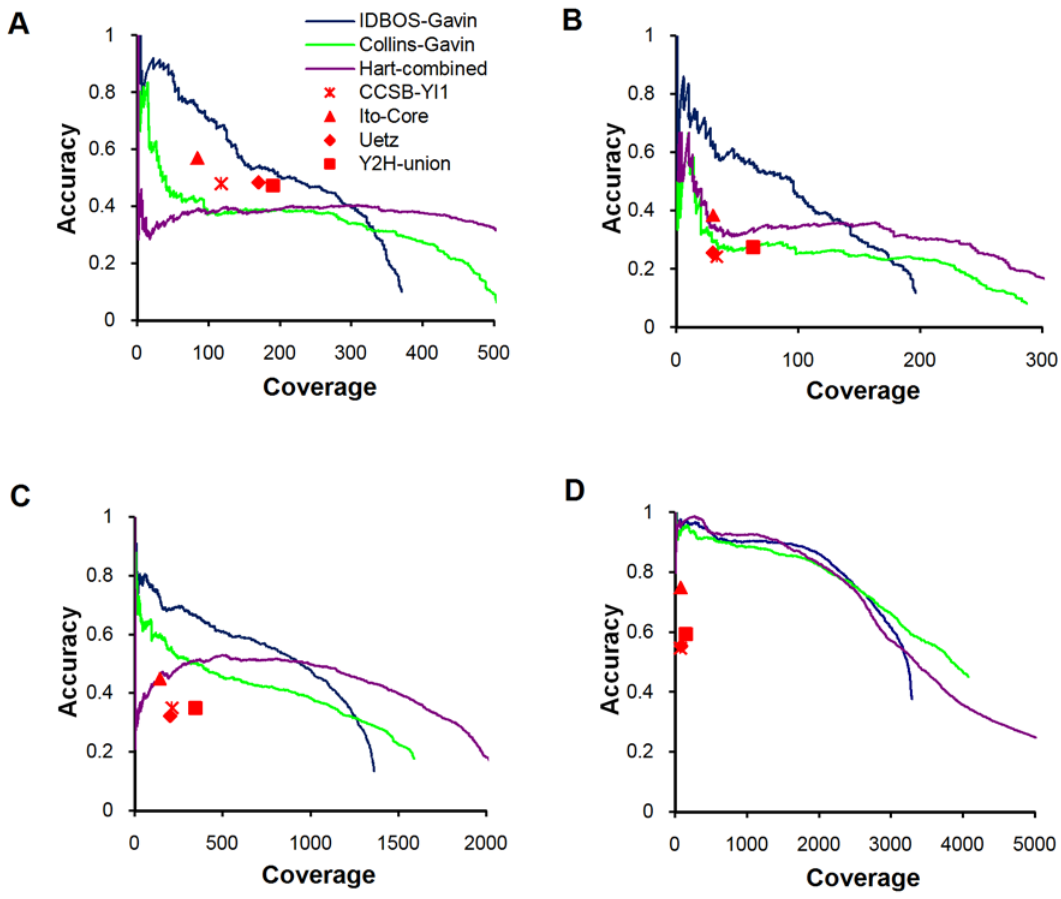
Figure 2. Evaluation of the IDBOS scoring scheme. Coverage versus accuracy data (see Materials and Methods) comparing the scoring schemes of IDBOS (this work) and Collins et al. [16], when applied to the purification data of Gavin et al. [8]. Four diverse reference interaction data sets were used: (A) BGS; (B) PCA; (C) SBMC2; and (D) MIPS. See Materials and Methods for full descriptions of these references. Also shown is the scored data of Hart et al. [17] (determined by multiplying individual results across the Gavin et al. [8], Krogan et al. [9], and Ho et al. [7] AP/MS data sets) and evaluations for Y2H data sets of Yu et al. [6] (CCSB-YI1), Ito et al. [4] (core subset), Uetz et al. [5], and a union of these data sets [6] (Y2H-union).